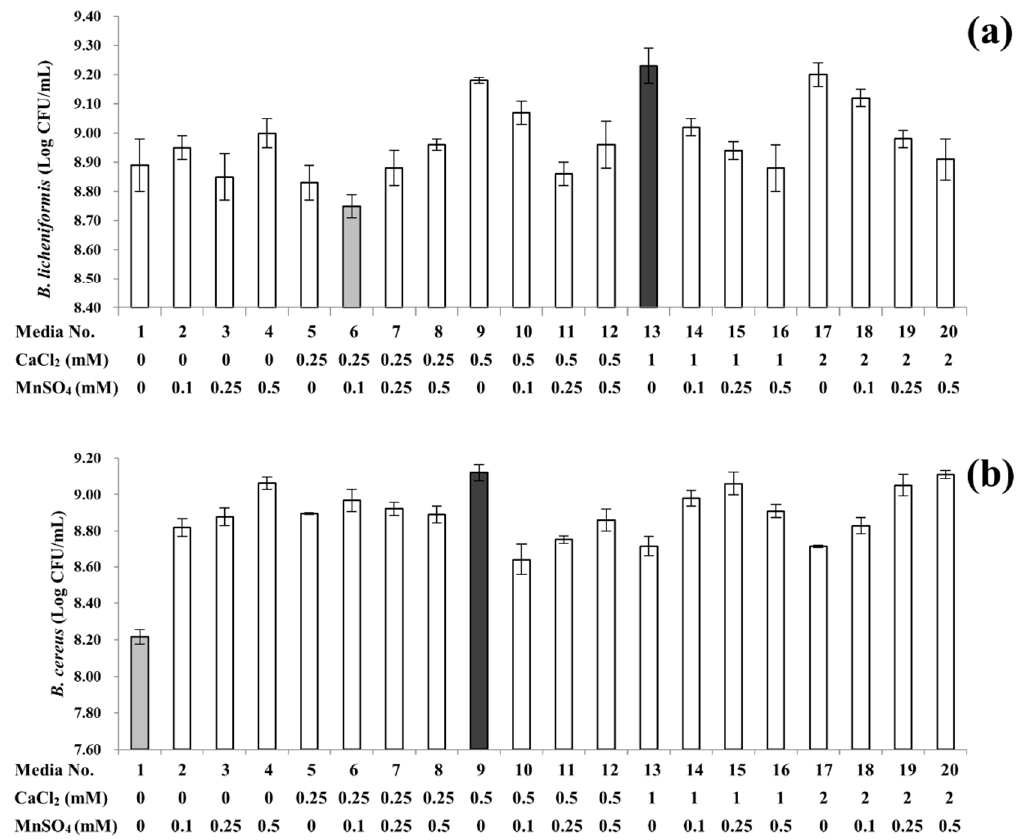
Figure 1. Sporulation profiles of Bacillus licheniformis ( a ) and B . cereus ( b ) under 20 different supplementation conditions. The light grey and dark grey columns highlight the lowest and highest spore yields, respectively. Error bars indicate standard deviations calculated from triplicate experiments.